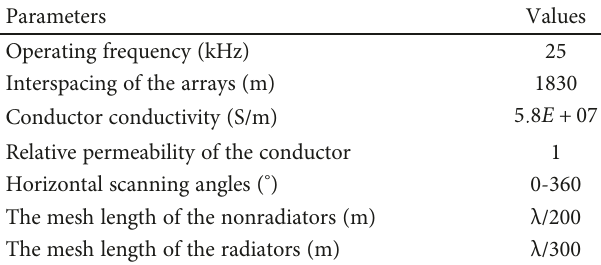
Table 8: List of the parameters of the antenna